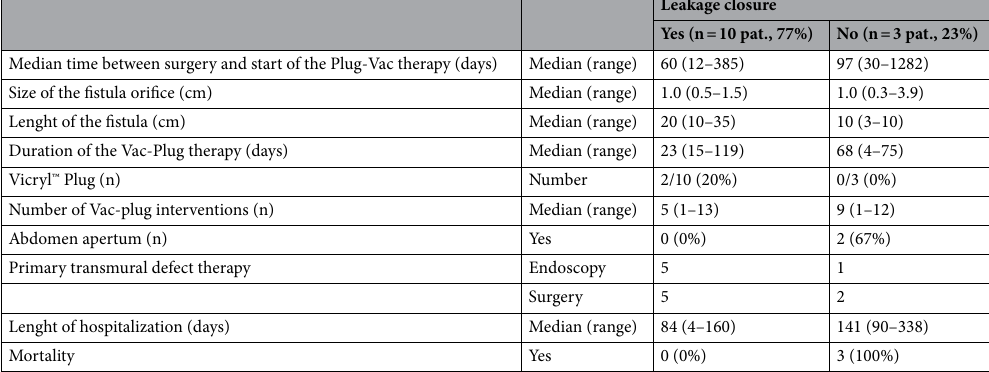
(Table 1). The endoscopic access to the leakage via the fistula’s cutaneous orifice was often straight and short allowing a much easier way to access the region of interest than the usual endoscopic approach. In contrast to the vacuum sponge therapy, we experienced far less ingrowth into the surrounding tissue with open-pore film drainage thus allowing for much less atraumatic replacement of the suction material. Of note, we did not observe any severe complications associated to the treatment applied, such as bleeding or septic complications caused by a dysfunctional system or a delayed replacement. This is in accordance with the observations made by Loske et al. 8 . Hence, the method appears to be safe and easy to learn.